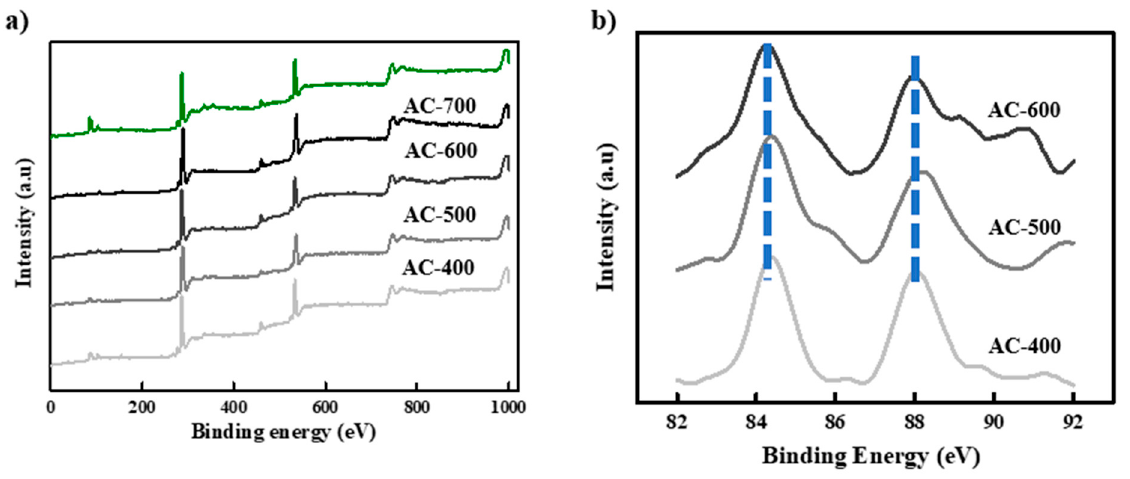
Figure 4. ( a ) XPS survey spectrum of various activated carbon-based catalysts; ( b ) high-resolution XPS spectra of Au.